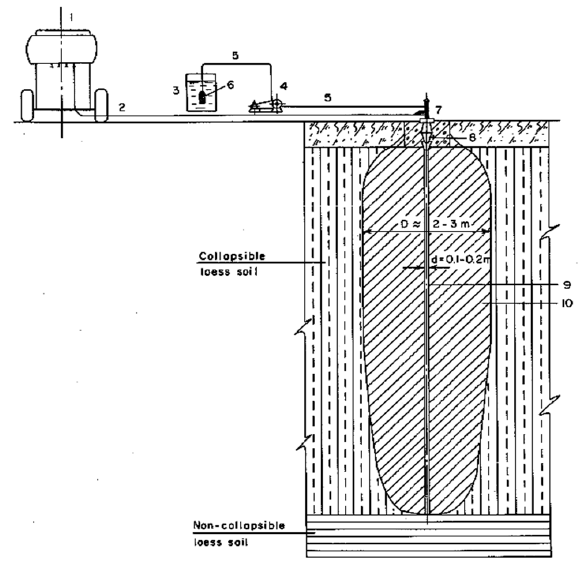
Figure 1. The conceptual diagram of the ground heating method using fossil fuel proposed by Litvinov [22].